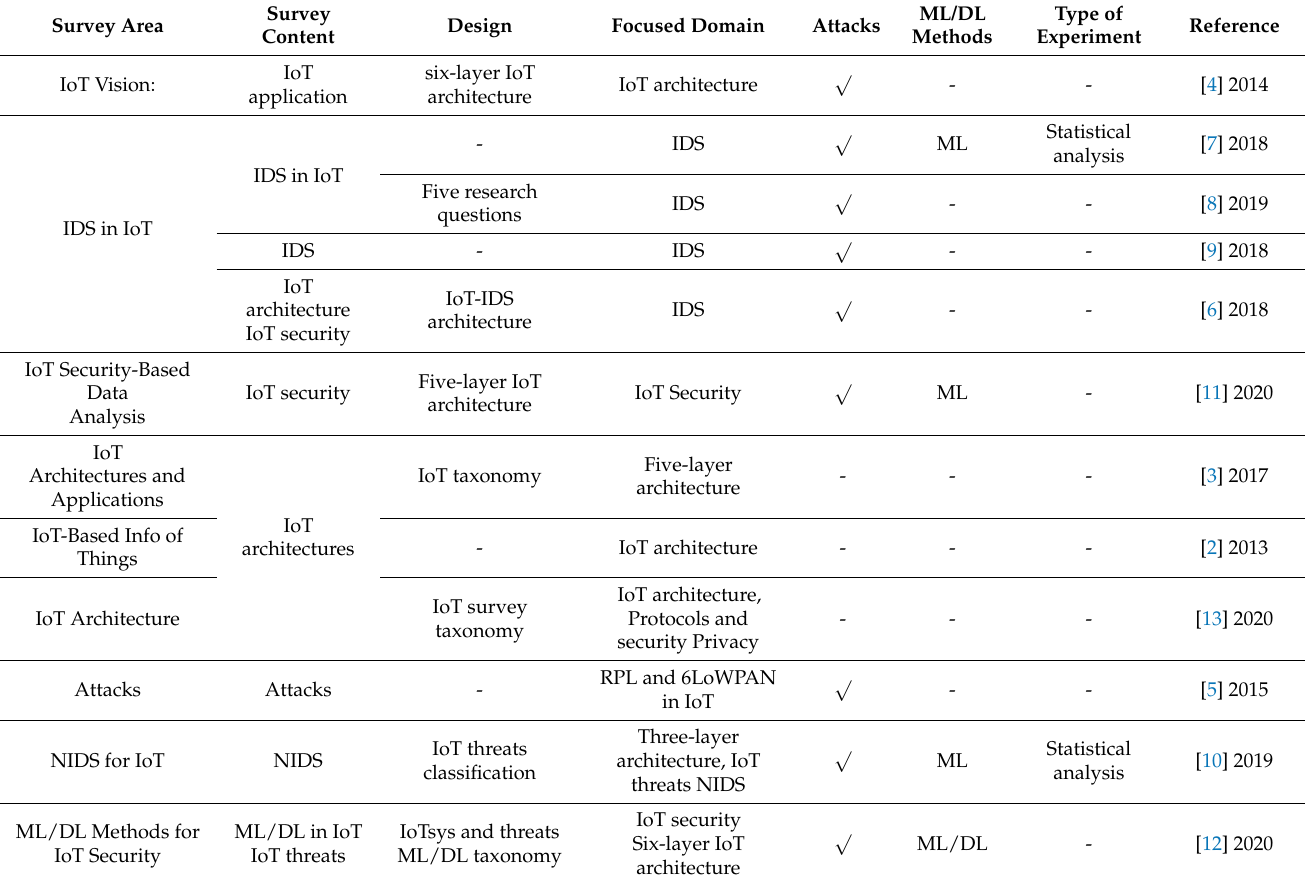
Table 1. Comparison of Intrusion Detection Systems (IDSs)